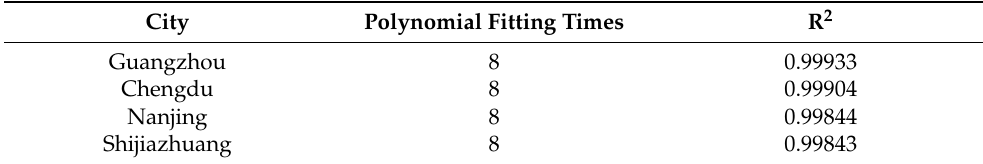
Table 2. Polynomial fitting times and goodness of